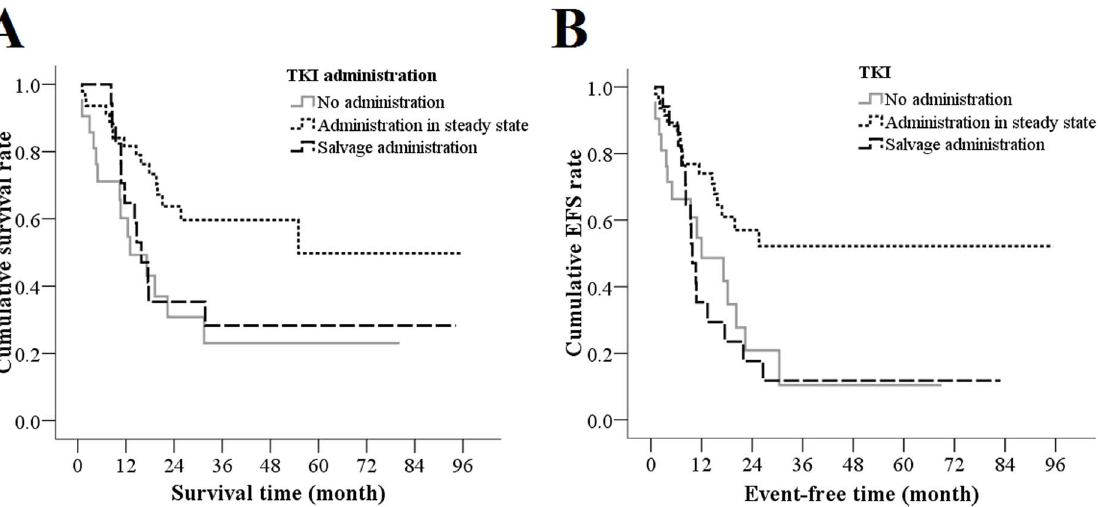
Figure 1. Prognosis for OS (A) and EFS (B) in Various TKI Administration Groups. The log-rank tests showed better prognosis in OS and EFS curves of those with TKI administration in steady stage compared to those without TKI administration ( P 5 0.008 and 0.012), and a significant difference was observed between the EFS curves of those with TKI administration in steady stage compared to salvage administration ( P 5 0.004).